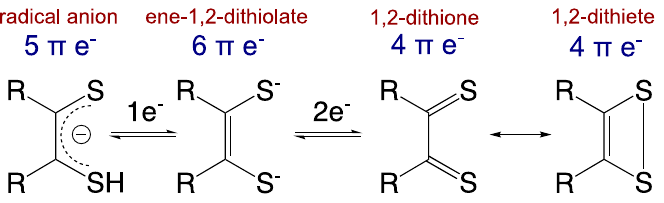
Figure 3. Dithiolene redox states and resonance structures for the oxidized dithione/dithiete forms. (Adapted with permission from Inorganic Chemistry , 2016, 55, 785–793. Copyright (2016) American Chemical Society).